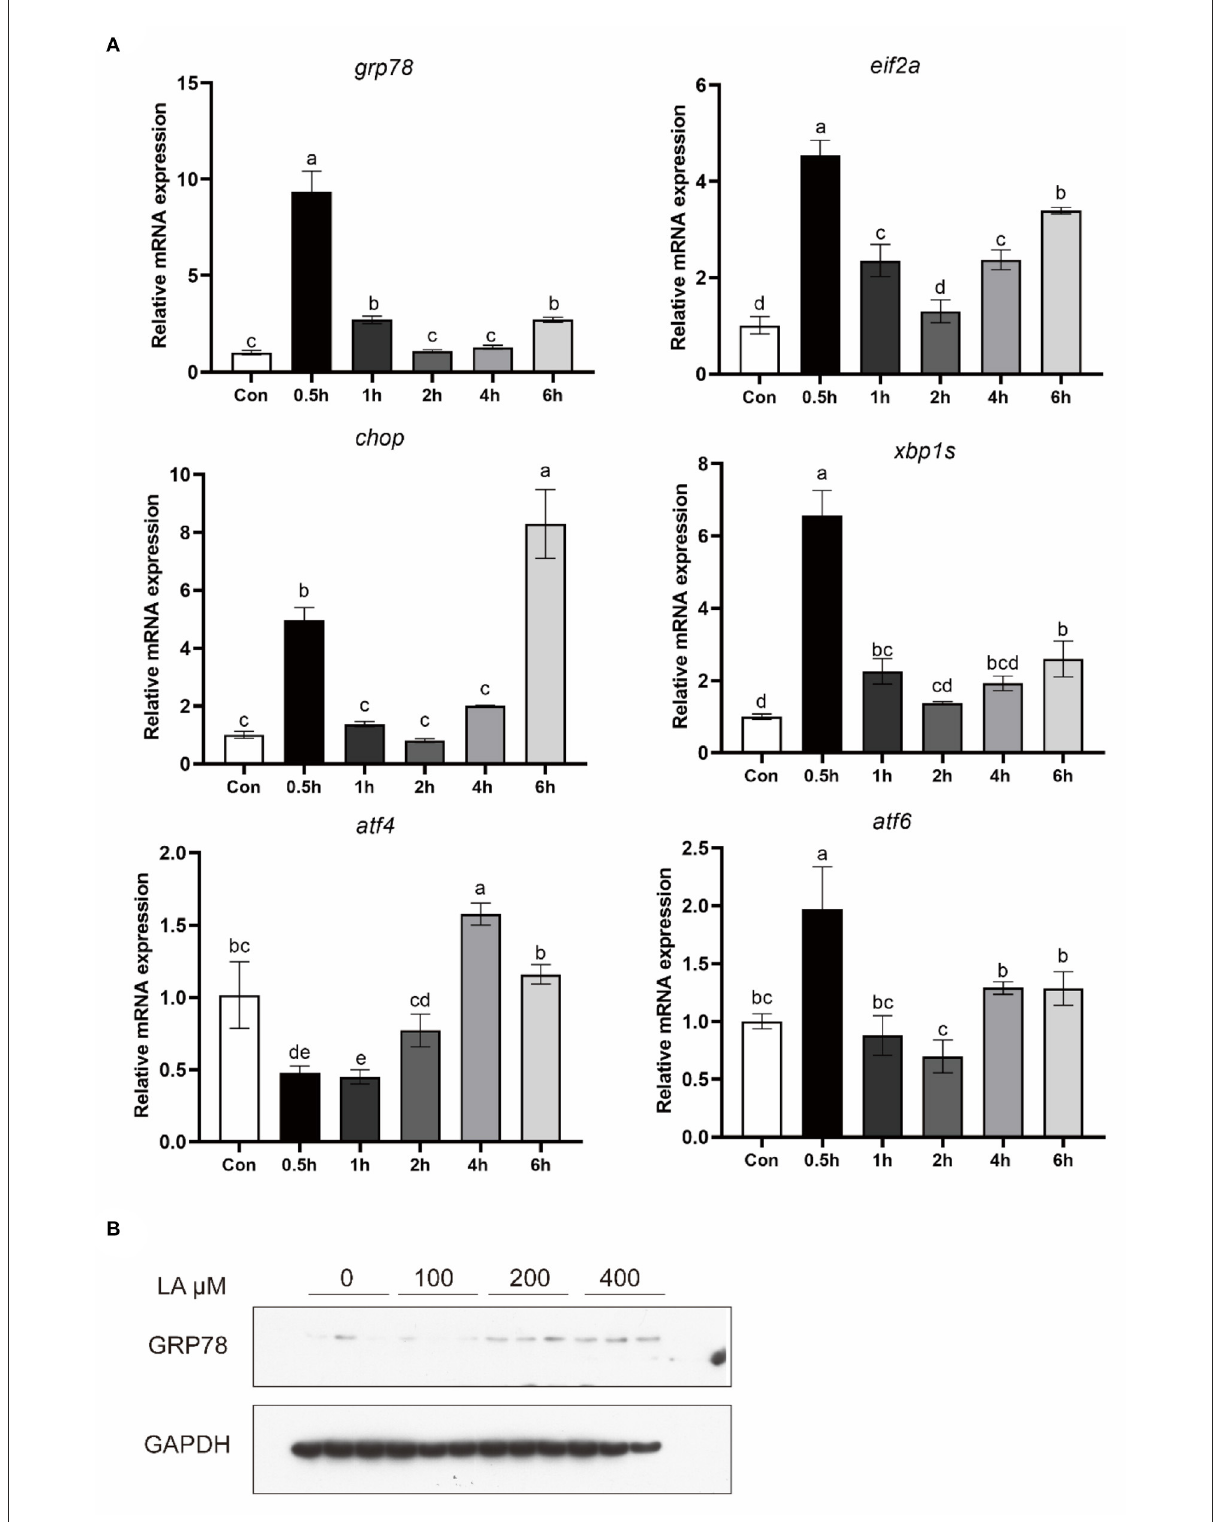
FIGURE2 Expression of (A) ER stress-related genes and (B) GRP78 protein levels in croaker macrophages treated with LA. The significance was analyzed by one-factor ANOVA and Duncan’s Multiple Range Test (means ± SEMs; n = 3). Means without the same label were considered different, P <